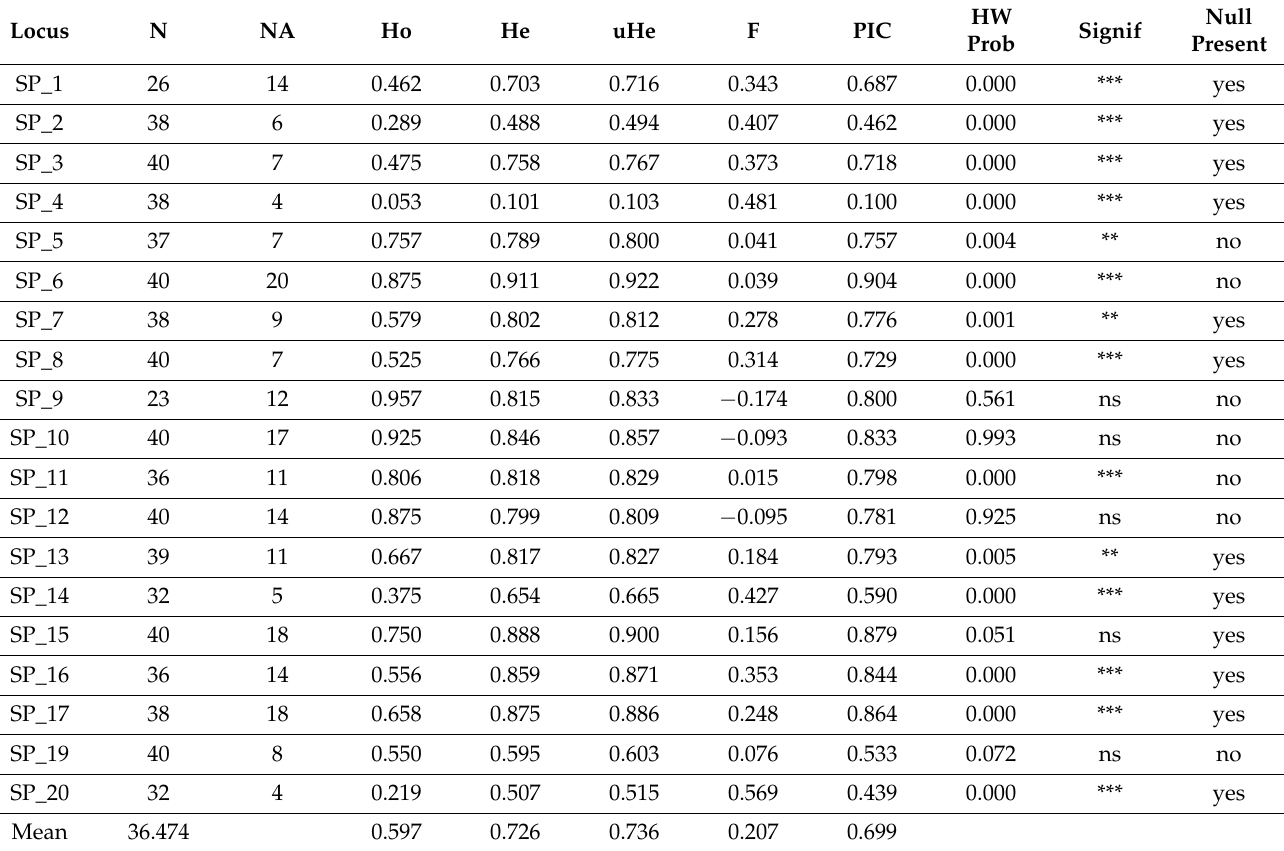
Table 2. Allelic diversity of S. pistillata microsatellite loci. Heterozygosity, F statistics, and polymor- phism by population and Chi-square tests for Hardy–Weinberg equilibrium for codominant Data. N = number of samples; NA = number of alleles; Ho = observed heterozygosity = no. of